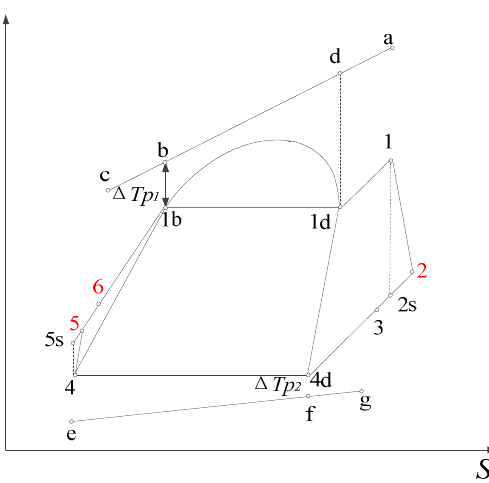
Figure 2. Typical T–s diagram for the regenerative ORC system.